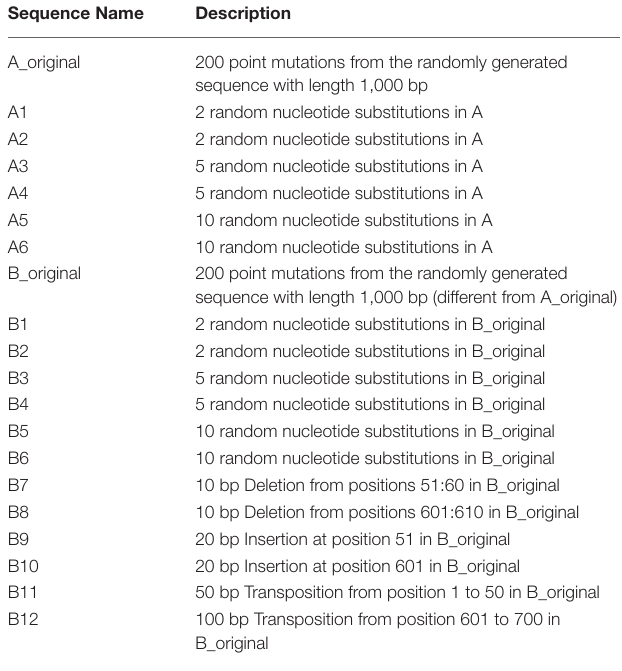
TABLE 4 | Description of DNA sequence mutation in simulated tests.